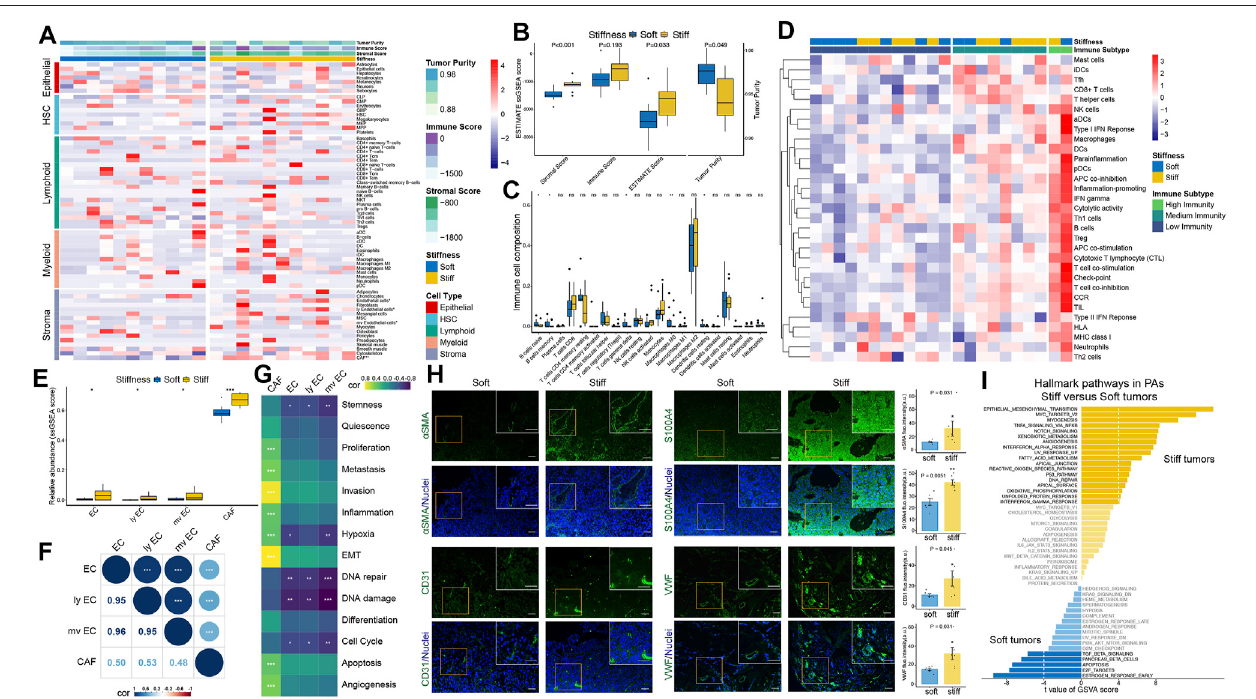
FIGURE 2 | Estimation of tumor immune microenvironment patterns associated with the stiffness of PAs. (A) Heatmap illustrating the cellular components of PA samples,includingepithelial,hematopoieticprogenitor,lymphoid,myeloid,andstromalcellclusters,quanti fi edbythexCellalgorithm. (B) Comparisonsofstromalscore, immune score, ESTIMATE score and tumor purity between soft and stiff tumors. (C) Comparisons of the abundances of 22 immune cells between soft and stiff tumors. (D) Heatmap illustrating the immune subtypes of PA patients, which were categorized based on the overall immune activity of tumors. (E) Comparisons of ECs, lymphatic ECs, microvascular ECs, and CAFs between soft and stiff tumors. (F) Correlation analysis of ECs, lymphatic ECs, microvascular ECs, and CAFs. (G) Correlation analysis ofECs, CAFs and 14 functionalprocesses of cancer cells. (H) Left panels: Immuno fl uorescence staining of CAF markers ( α SMA and S100A4) and EC markers (CD31 and VWF) (green) in soft and stiff tumors. Cell nuclei were counterstained with DAPI (blue). Scale bar: 50 μ m. Right panels: Quanti fi cation of the fl uorescence intensity of four cell markers between soft and stiff PAs. a. u., arbitrary unit. (I) The differential hallmark pathways associated with stiff and soft tumors. * means p < 0.05, ** means p < 0.01, and *** means p < 0.001.